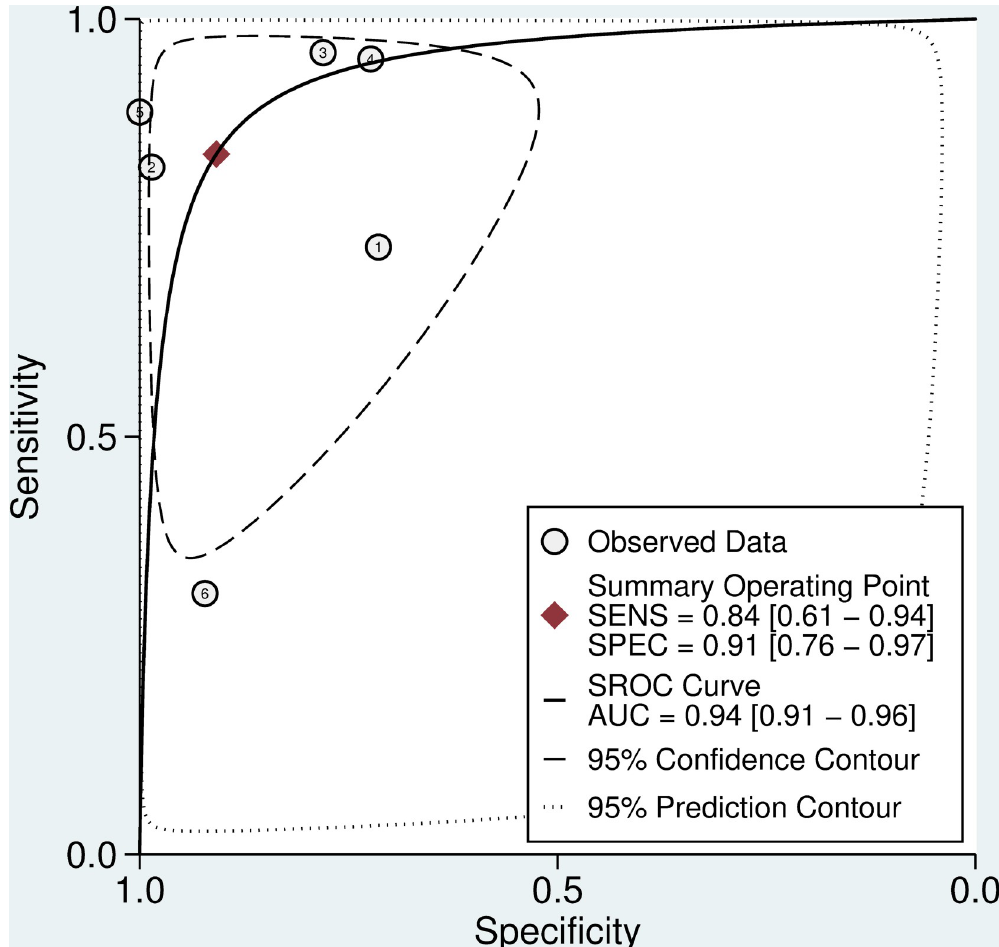
Fig 8. SROC curve for 20WBCT at detecting coagulopathy. SROC curves for 20WBCT at detecting severe coagulopathy defined as INR > 5 or fibrinogen < 50 mg/dL.